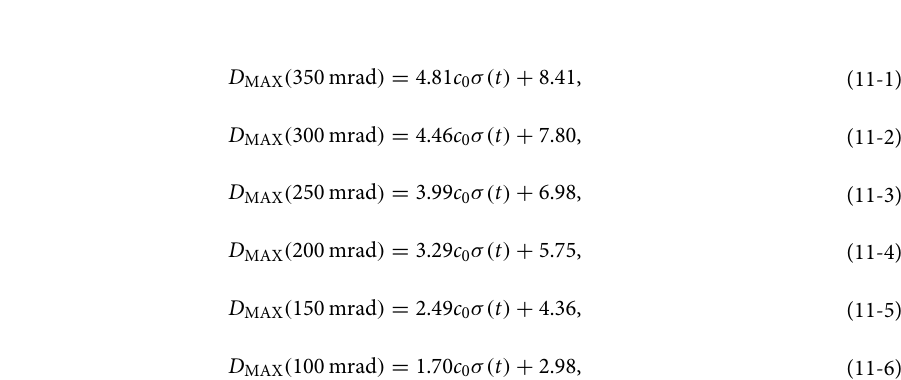
Figure 5. Time-dependent standard deviation (SD) of Δ t (σ( t )) averaged over single (blue lines), double (orange lines) and triple (gray lines) OCXO